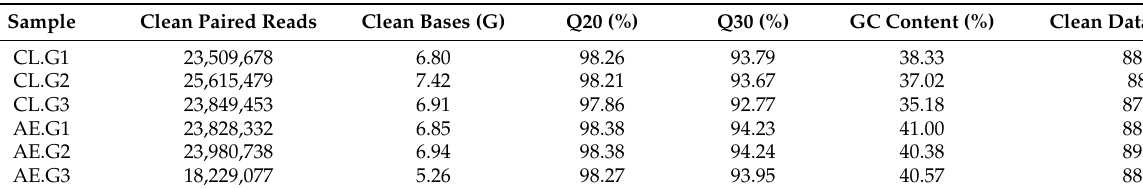
Table 2. The Illumina sequencing data.